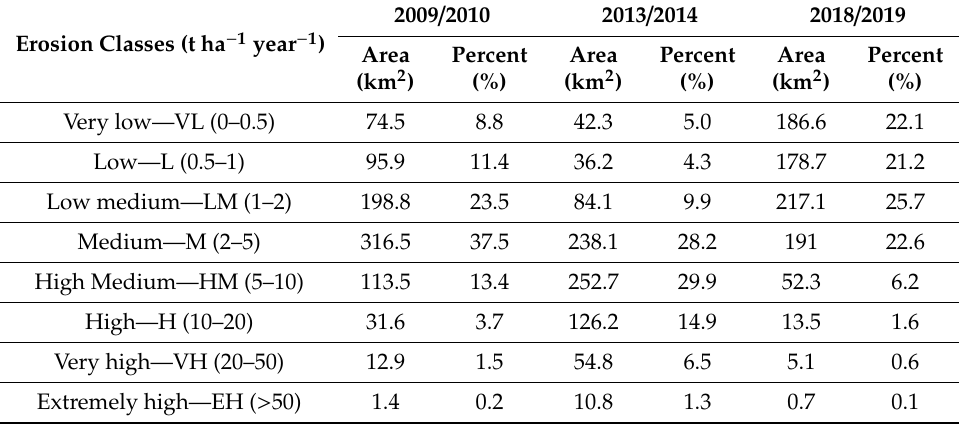
Figure 4. Erosion classification map of the Northern Al-Kabeer watershed in ( a ) 2009 / 2010, ( b ) 2013 / 2014 and ( c ) 2018 / 2019. Table 1. Soil erosion classes in 2009/2010, 2013/2014 and 2018/2019.